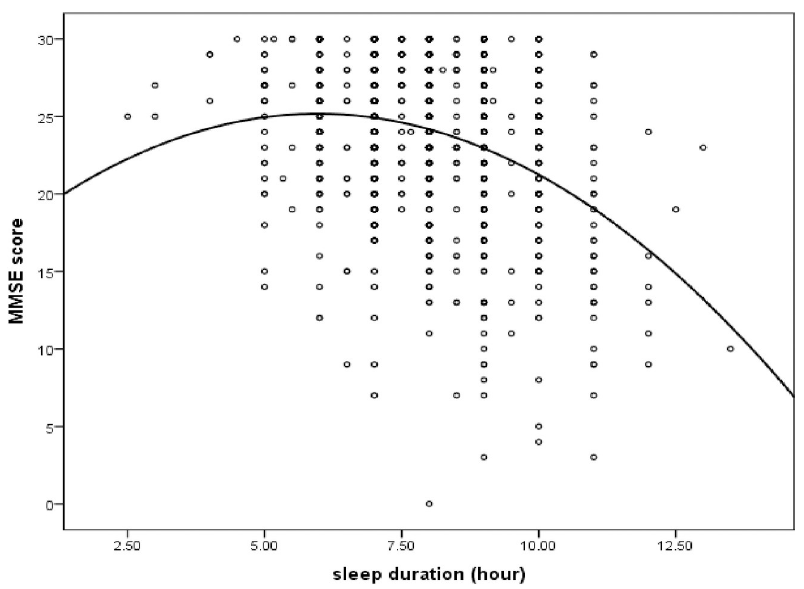
Fig 2. A U-shaped association between sleep duration and MMSE score.